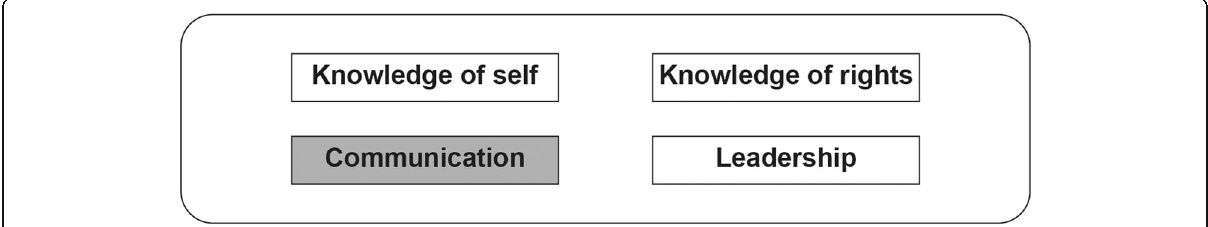
Fig. 1 Test ’ s conceptual model of self-advocacy (Test et al., 2005). Knowledge of self and knowledge of rights are foundational, communication is described as essential (shaded box), and leadership is seen as non-essential for self-advocacy. We refer to these components of self-advocacy as “ Test ’ s components ” or “ original components ” of